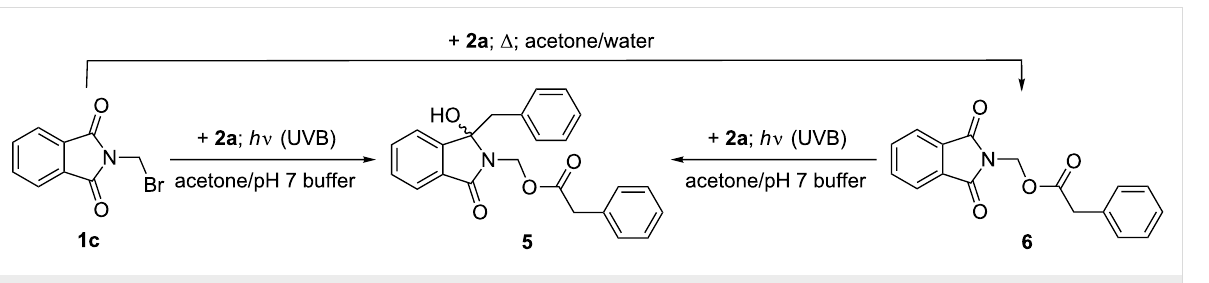
Scheme 4: Formation of 5 by photodecarboxylative